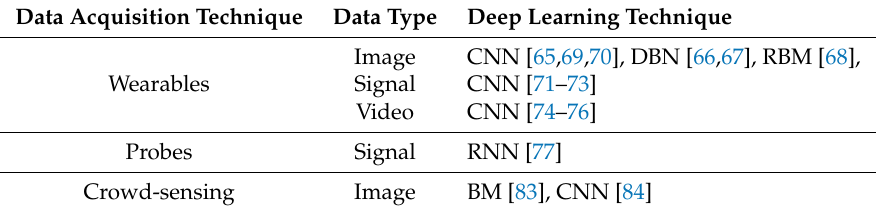
Table 2. Summary of data acquisition methods, data types and examples of deep learning technique used. Three types of data acquisition categories are defined, which acquire images, one-dimensional signals and videos. CNN, DBN, restricted Boltzmann machine (RBM) and BM are the deep learning methods that are used to analyse big sensed